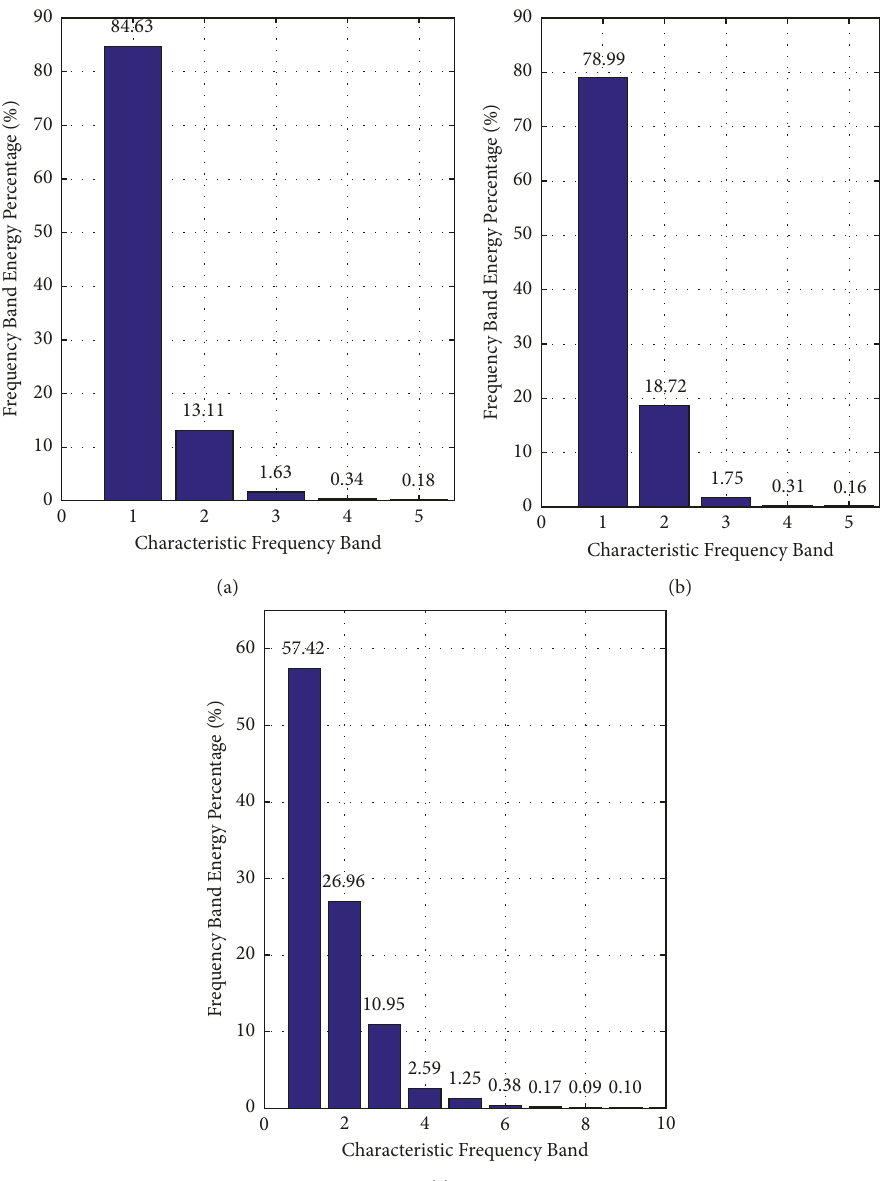
Figure 4: Energyprobabilitydistribution ofearthquakerecordsat53BCJ(72.6kmfromtheepicentre):(a)east-west;(b)north-south;and(c)